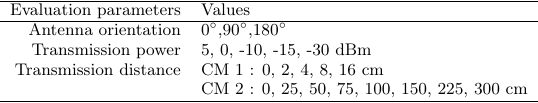
Table 3: Set of physical parameters. Repeated for CM 1 and CM 2